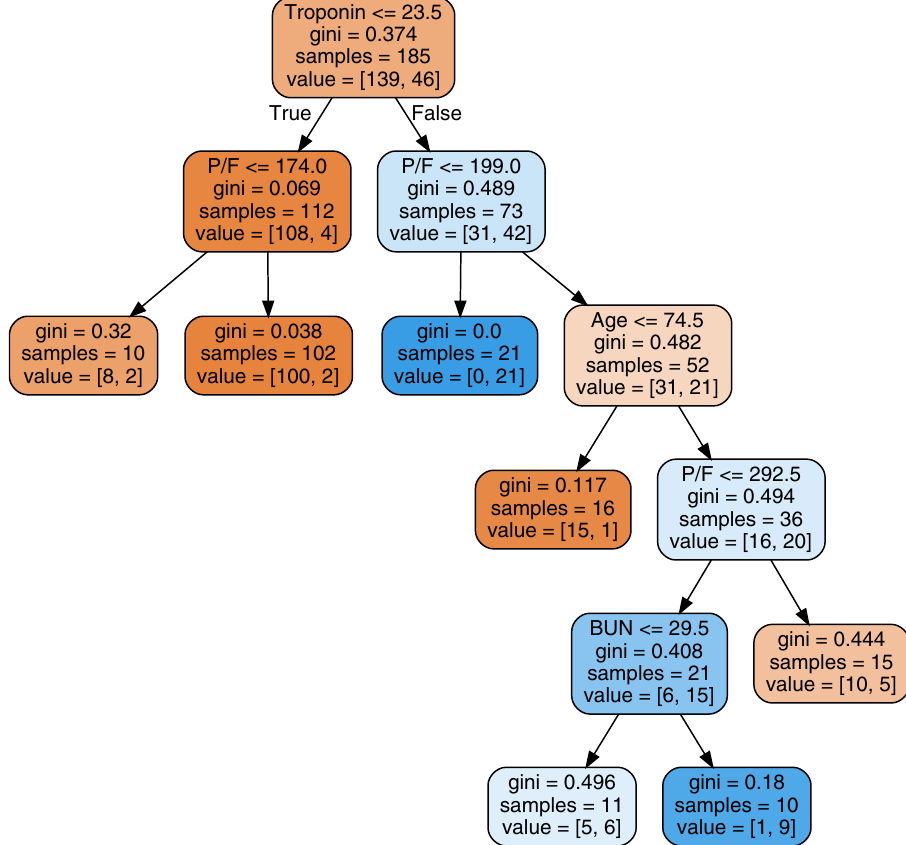
Figure 4. Decision tree trained on all 185 patients that have no missing values among the 6 selected clinical variables. Each node of the tree contains a condition on a clinical variable. We also include the number of patients, and the way they are divided into the two classes (discharged/deceased). The colour of the node shows whether patients are in the discharged class (orange) or deceased class